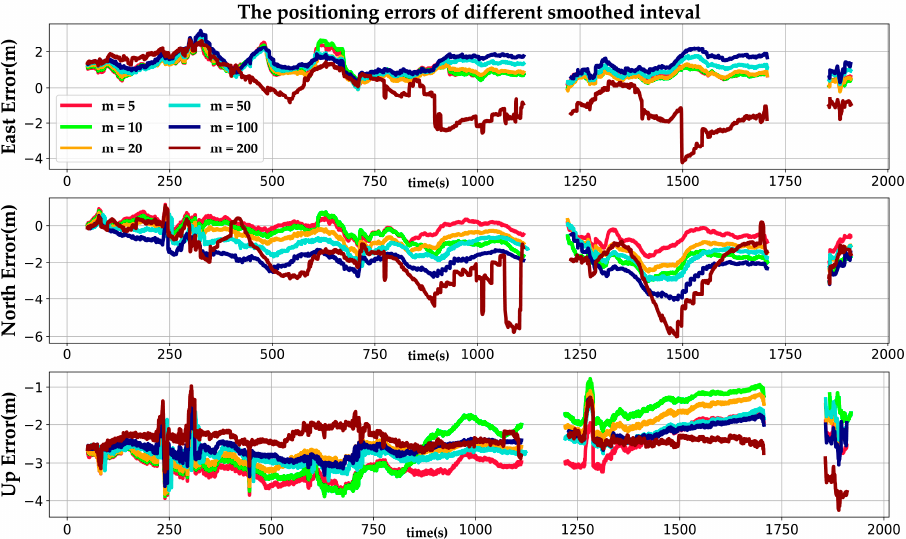
Figure 11. The positioning errors with different smoothed interval settings ( m = 5, 10, 20, 50, 100, and 200).